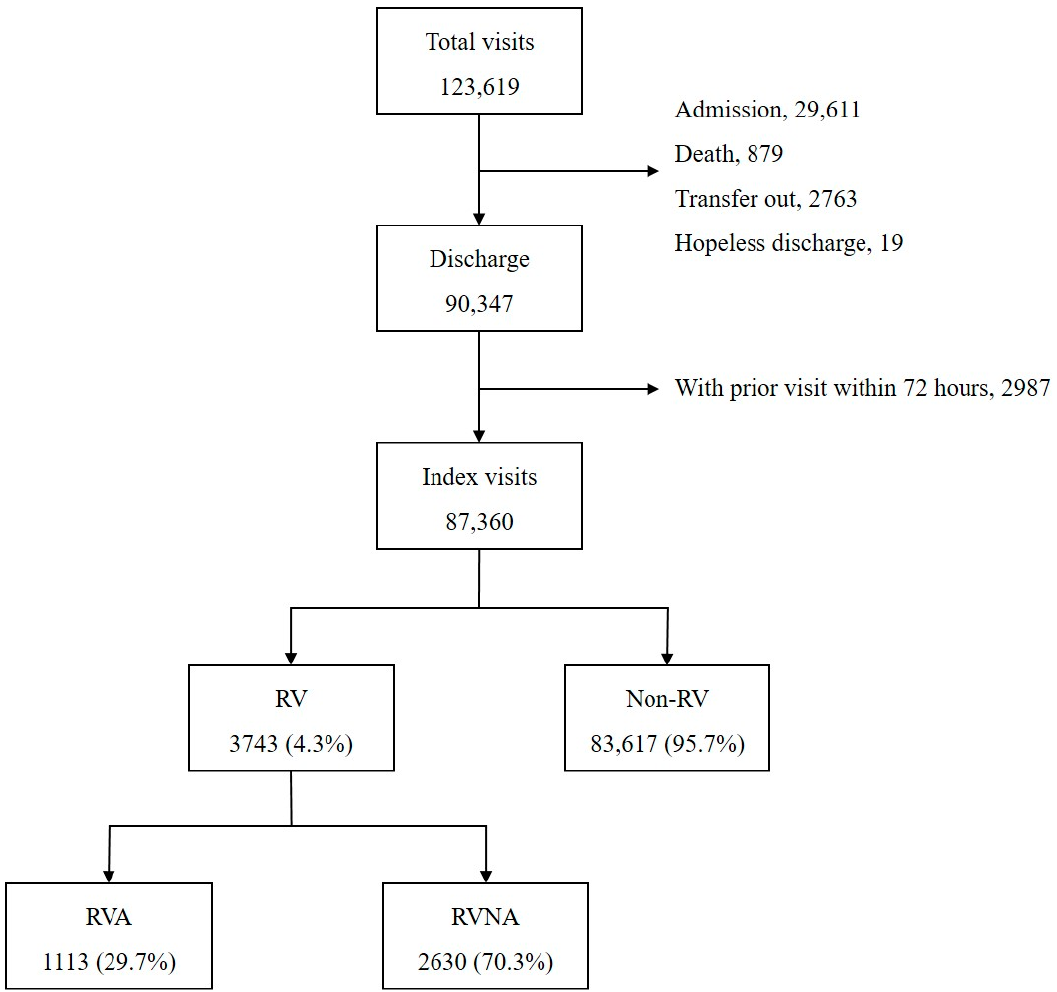
Figure 2. Study patient disposition. RV, return visit; RVA, return visit with admission; RVNA, return visit with no